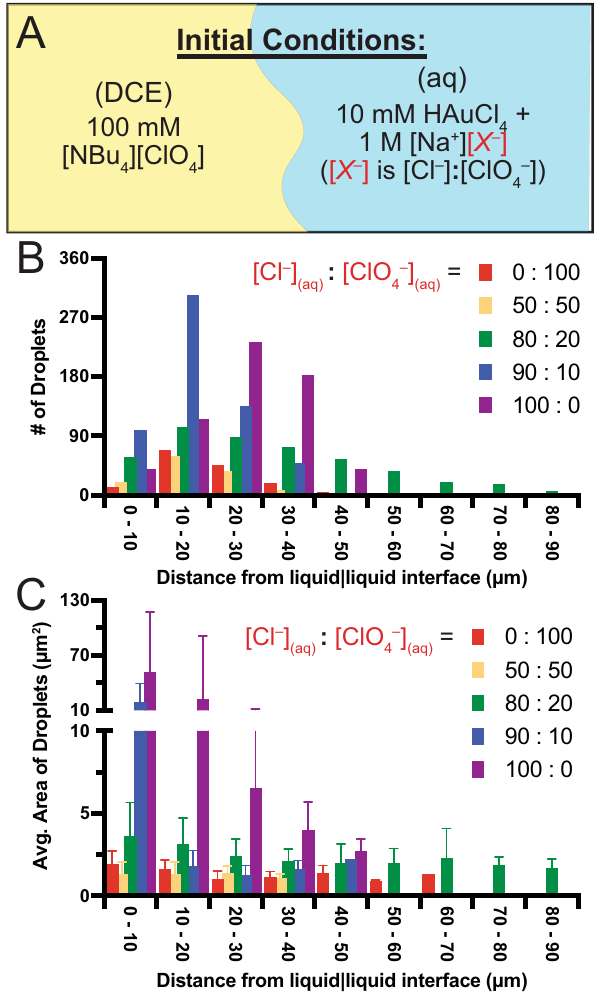
Fig. 5 | Degree ofdisequilibrium affects the extent ofemulsi fi cation. A Graphic showing initial conditions where the DCE phase contains 100mM of a tetra- butylammonium perchlorate, while the aqueous phase contains 10mM HAuCl 4 with different ratios of sodium chloride and sodium perchlorate (but always 1M total supporting electrolyte concentration). Histograms show the number of emulsiondropletsmeasured( B )andtheaverageareaofmeasureddroplets( C )as afunctionofdistancefromtheliquid|liquidinterface.Alldropletsweremeasured 10min from the initial time of contact. Ratios of [Cl – ] (aq) :[ClO 4 – ] (aq) used were 0:100 (red), 50:50 (yellow), 80:20 (green), 90:10 (blue), and 100:0 (purple). The errorbars in C arestandard deviations about the mean forN equal to the number of droplets identi fi ed in that region (from B ). Source data are provided as a Source Data fi